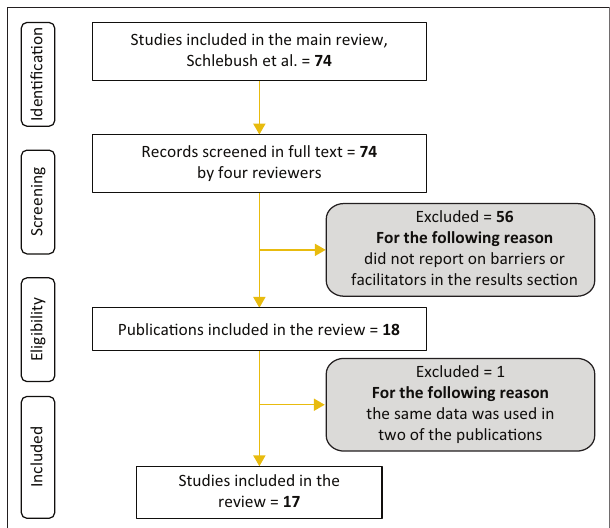
FIGURE 1: PRISMA flow